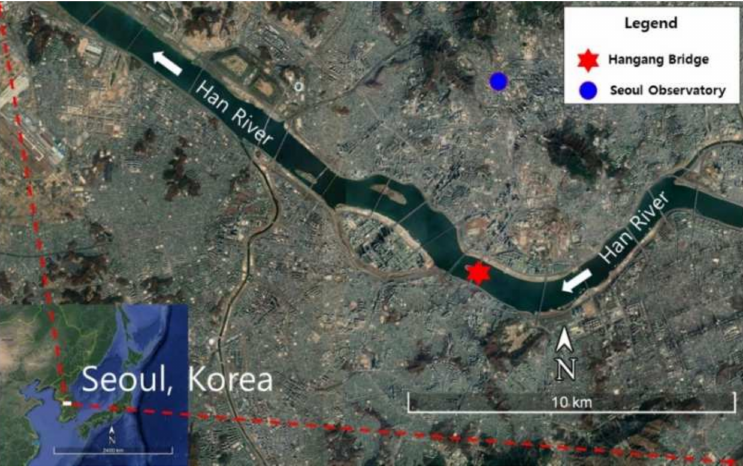
Figure 4. Map of the Han River basin in Korea (Google Earth